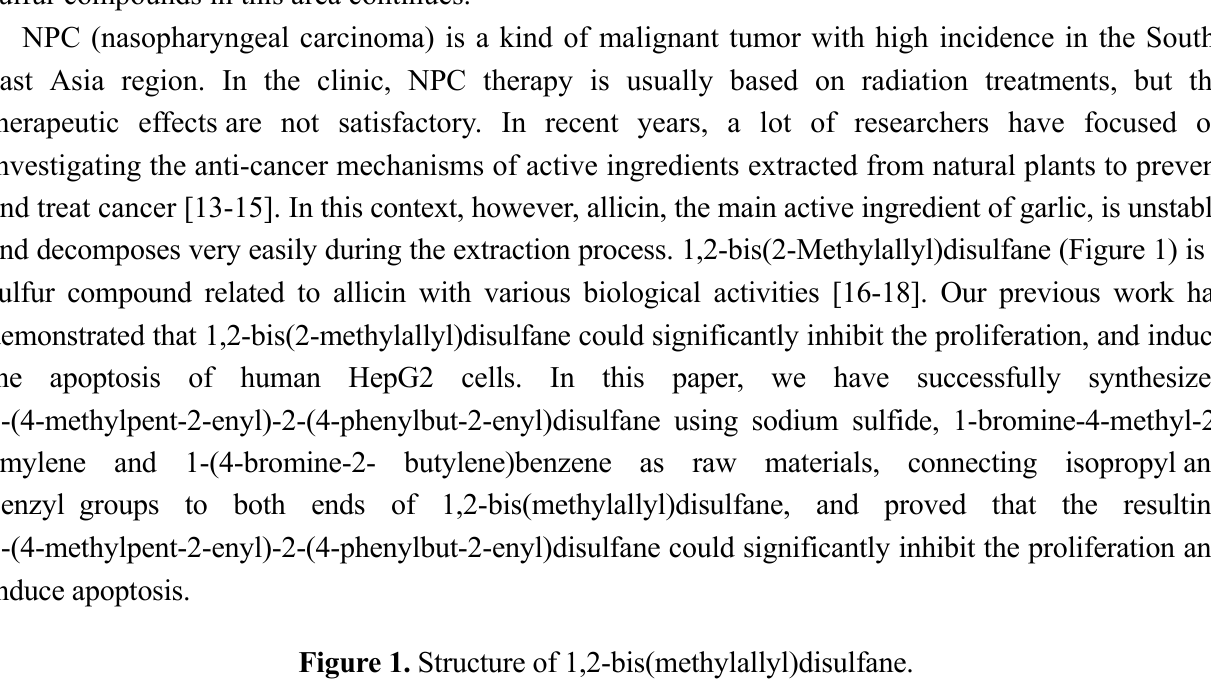
Figure 1. Structure of